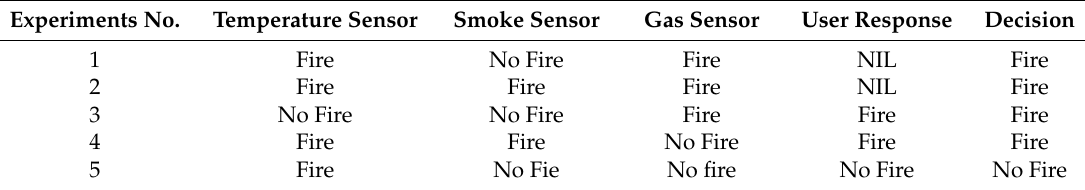
Table 3. Table of the results from our five experiments. Table 4. Comparison of the proposed method with some existing